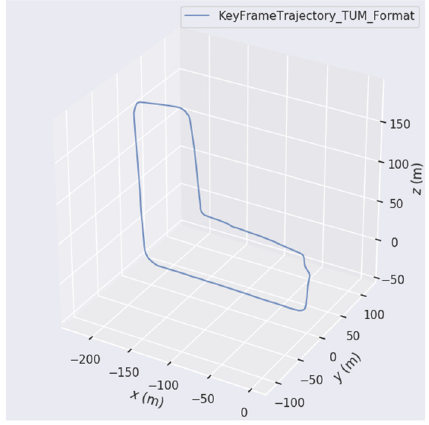
Figure 12. Outdoor road positioning track map.